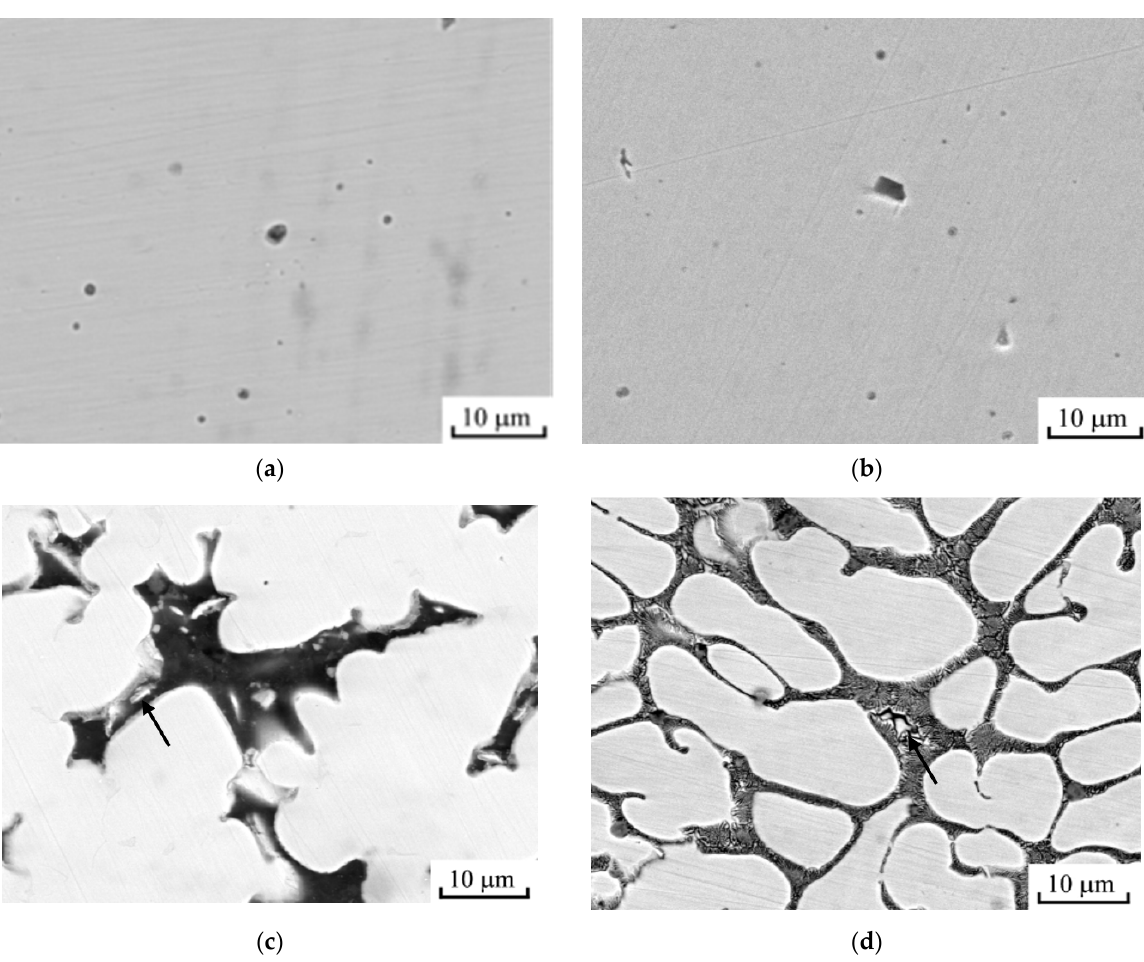
Figure 10. Microstructure of the polished upper surface part in the CoCrFeNiMn HEA coatings after corrosion test: ( a ) 50 A, ( b ) 60 A, ( c ) 70 A and ( d ) 80